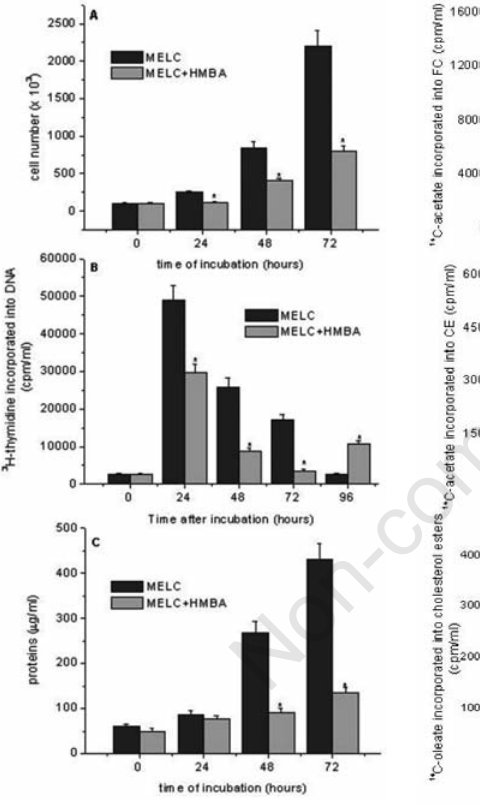
MELC. Reverse transcription-polymerase chain reaction analysis was performed as described in Materials and